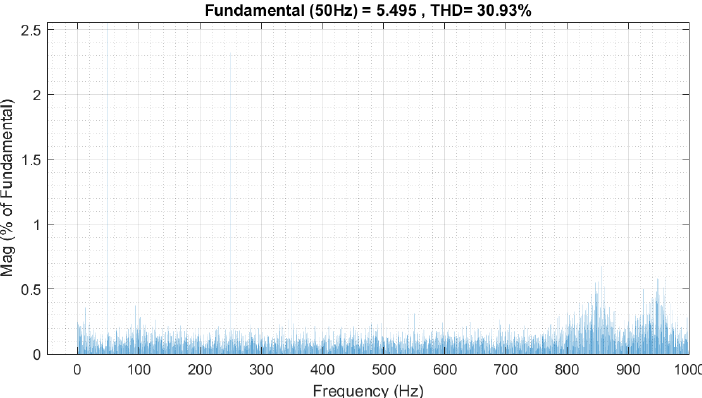
Figure 18. A 6- bus system current harmonic spectrum when SOC (state of charge) is 90% . Figure 18. A 6-bus system current harmonic spectrum when SOC (state of charge) is